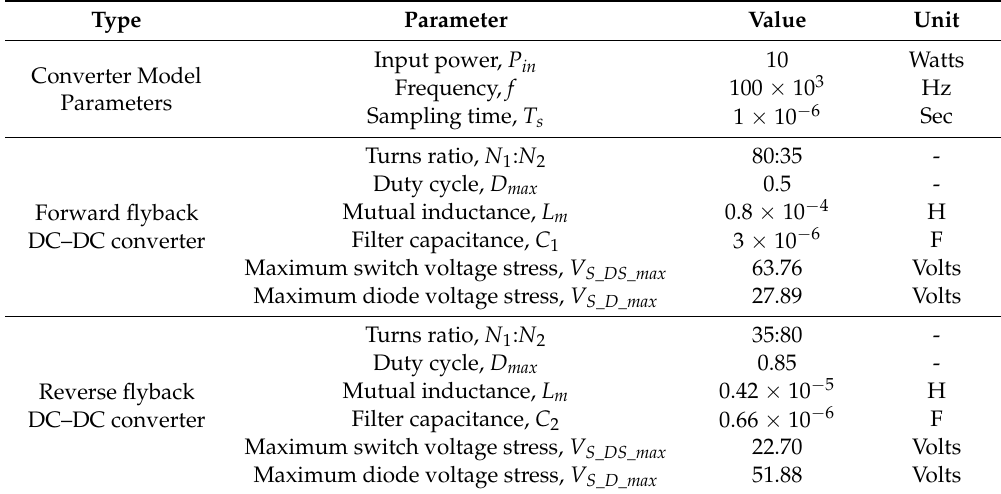
Table 1. Flyback DC–DC converter model